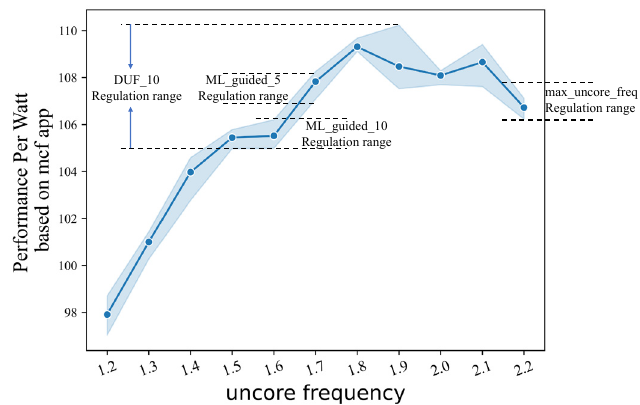
Figure 5. Variation of PPW at different uncore frequencies in the mcf app and different models’ regulation ranges.